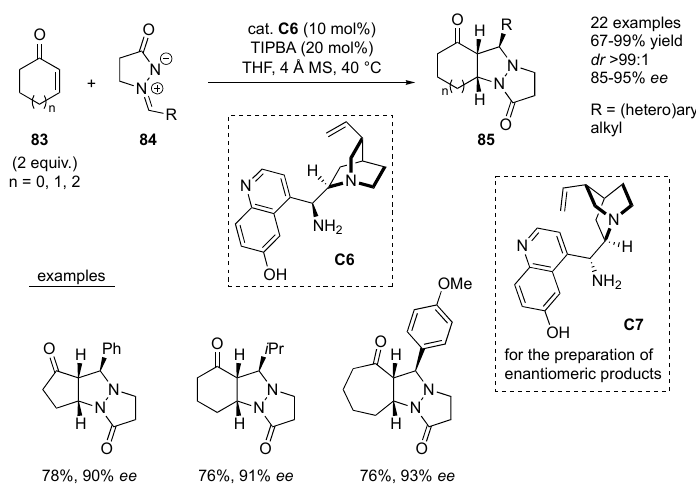
Scheme 27. Cycloaddition of N , N -cyclic azomethine imines to 2-cyclopenten-, 2-cyclohexen-, and 2-